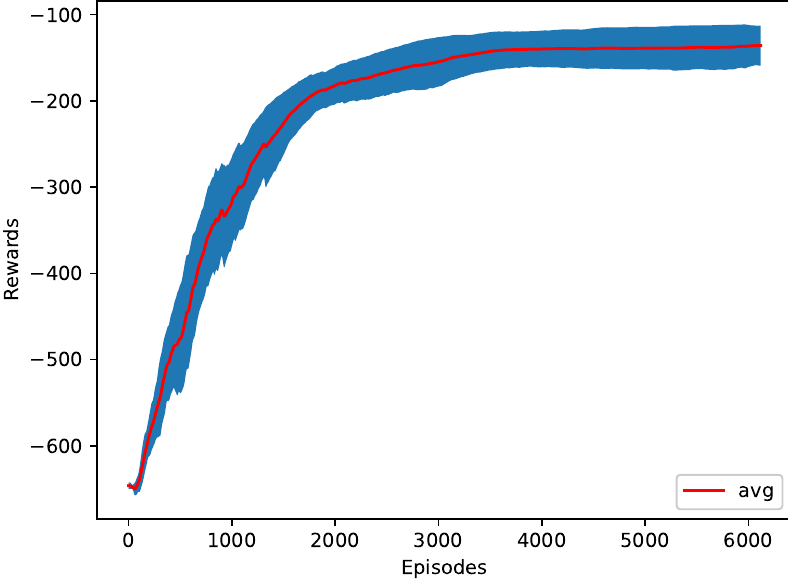
Figure 15. The training plot of the multi-objective reward function (Case